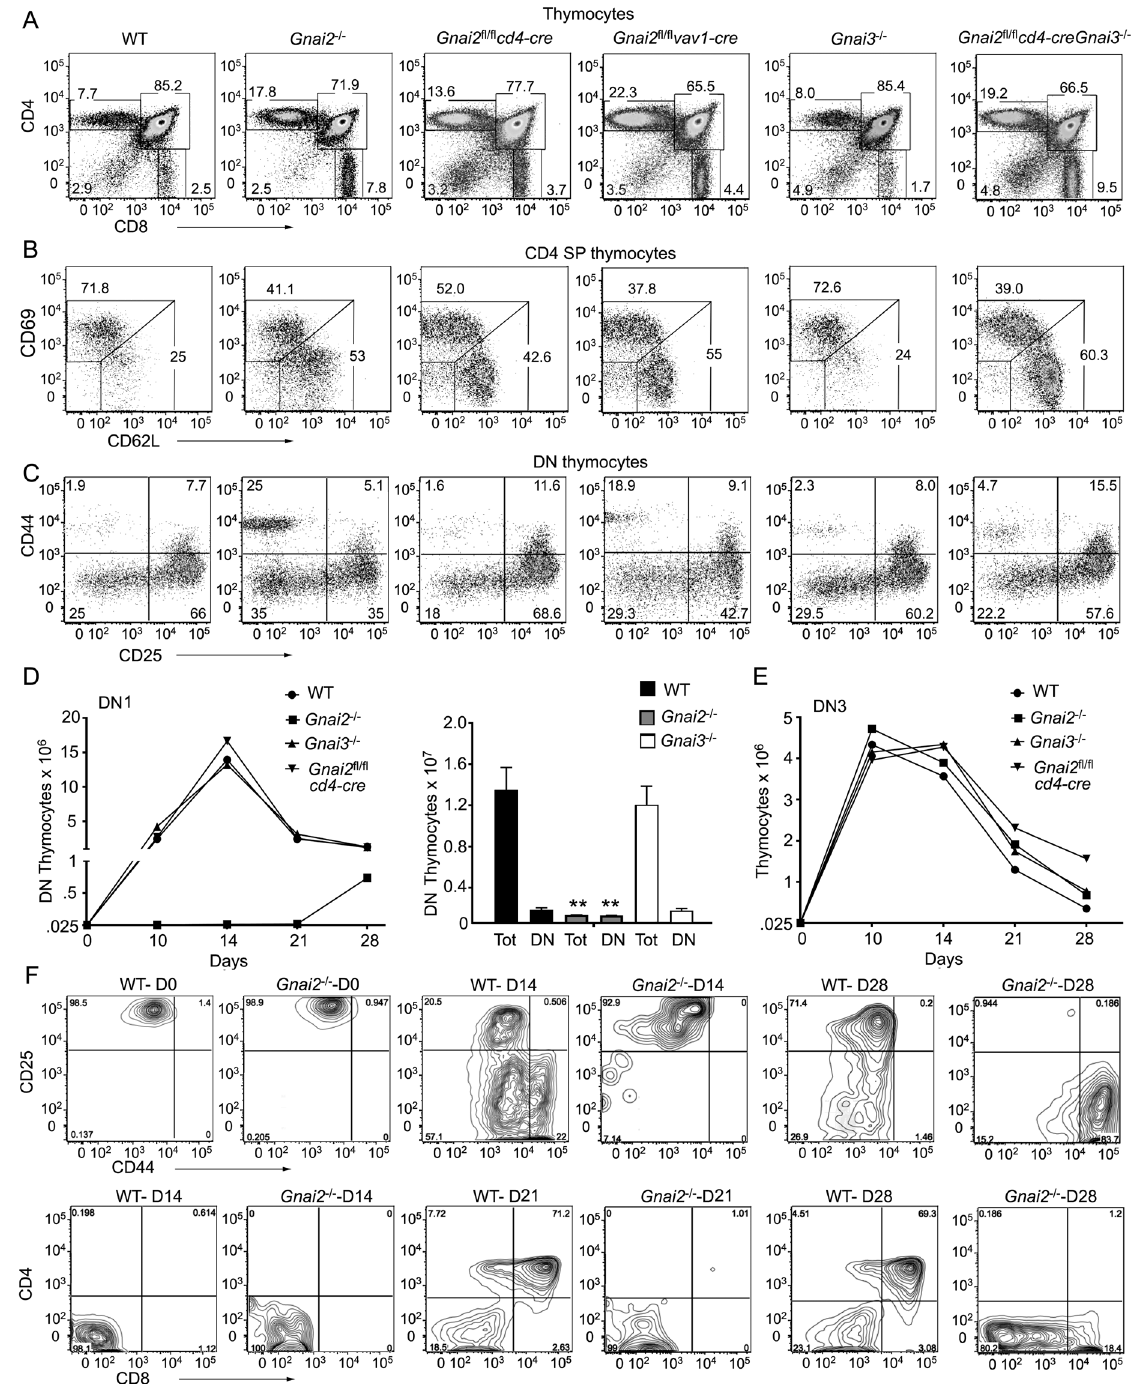
Figure 1. Loss of Gnai2 inhibits early thymocyte development and causes SP mature thymocytes to accumulate. ( A ) Representative flow cytometry of thymocytes from indicated mice examining CD4 versus CD8 expression. ( B ) Representative flow cytometry of thymocytes from indicated mice gated on CD4 SP thymocytes for their expression of CD62L and CD69. ( C ) Representative flow cytometry of thymocytes from indicated mice gated on DN thymocytes for their expression of CD44 and CD25. ( D ) Growth and differentiation of FACS sorted DN1(Lin − CD25 − CD44 + CD117 + ) thymocytes purified from the indicated mice and cultured on OP9-DL1 cells in the presence of IL-7 (1 ng/ml) for 28 days. The numbers of total and DN thymocytes recovered at Day 28 from each of the genotypes is shown to the right. ( E ) Growth of FACS sorted DN3 thymocytes from the indicated mice cultured on OP9-DL1 cells in the presence of IL-7 (1 ng/ml) for 7 days. Experiments were performed a minimum of 3 times. ** p < 0.005 (Student’s t -test). ( F ) Representative flow cytometry plots from part D comparing WT and Gnai2 − / − DN1 thymocytes cultured for various durations on OP9-DL1